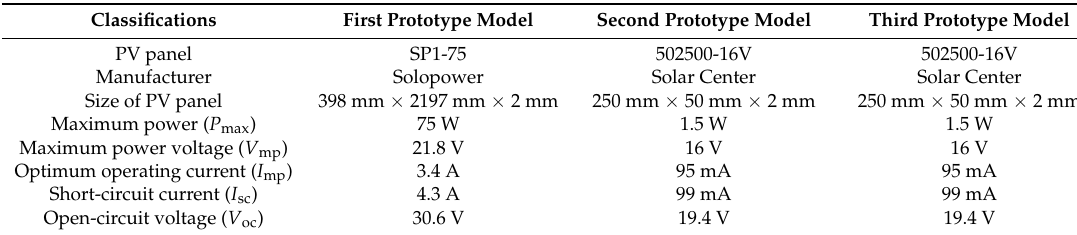
Table 4. Specifications of the PV panel by prototype